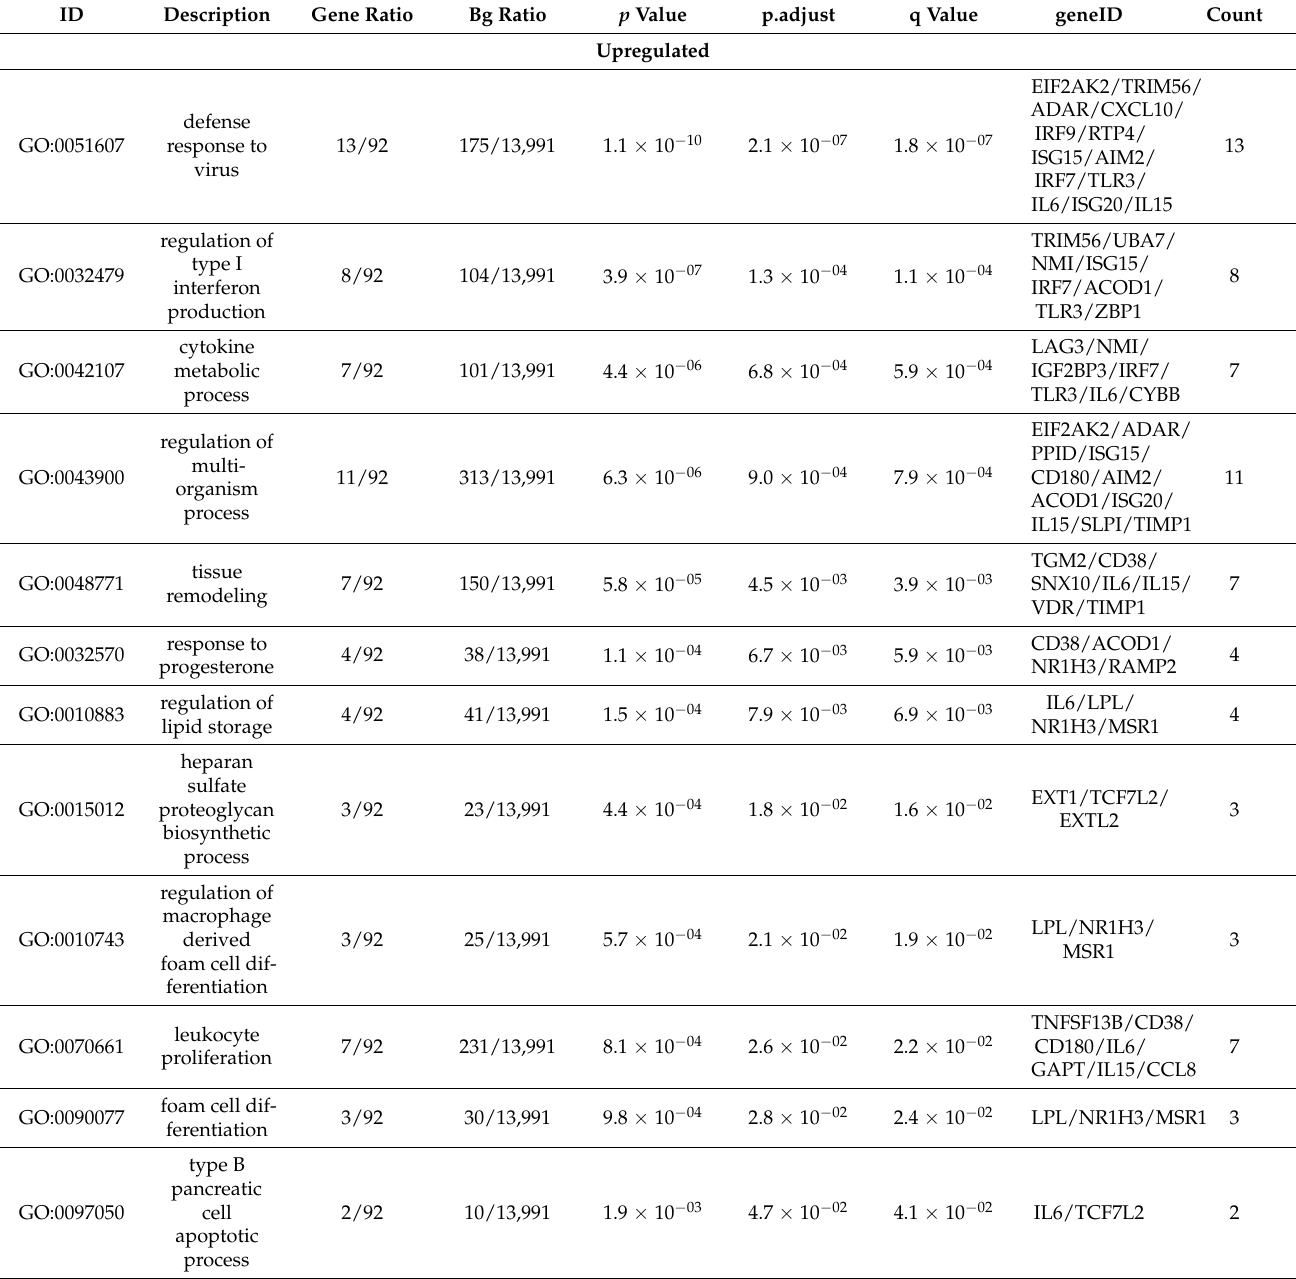
Table 1. Enriched GO terms based on differentially expressed genes in EHM horses. GO term enrichment was performed on the gene list of within group up- and down-regulated genes unique to EHM